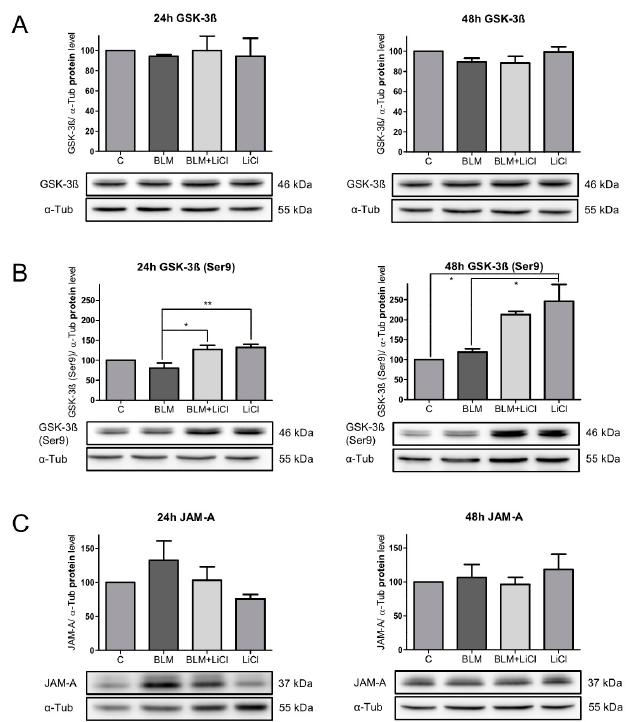
Figure 3. Expression of total GSK-3 β ( A ), GSK-3 β (Ser9) ( B ), and JAM-A ( C ) were analyzed by Western blot after 24 h and 48 h treatment with 100 mU / mL BLM, 100 mU / mL BLM, and 10 mM LiCl or 10 mM LiCl alone. Equal protein amounts of cell lysates were used in SDS-PAGE and analyzed by Western blot. α -Tub served as the loading control. Untreated cells were used as the control and normalized to 100%. Representative blots from three independent experiments are shown. Charts presented as mean ± SEM ( n = 3) of GSK-3 β / α -Tub, GSK-3 β (Ser9) / α -Tub, and JAM-A / α -Tub. P -values: 24 h GSK-3 β 0.9447; 48 h GSK-3 β 0.0625; 24 h GSK-3 β (Ser9) 0.0046; 48 h GSK-3 β (Ser9) 0.0066; 24 h JAM-A 0.186; and 48 h JAM-A 0.6123. * p < 0.05, ** p <